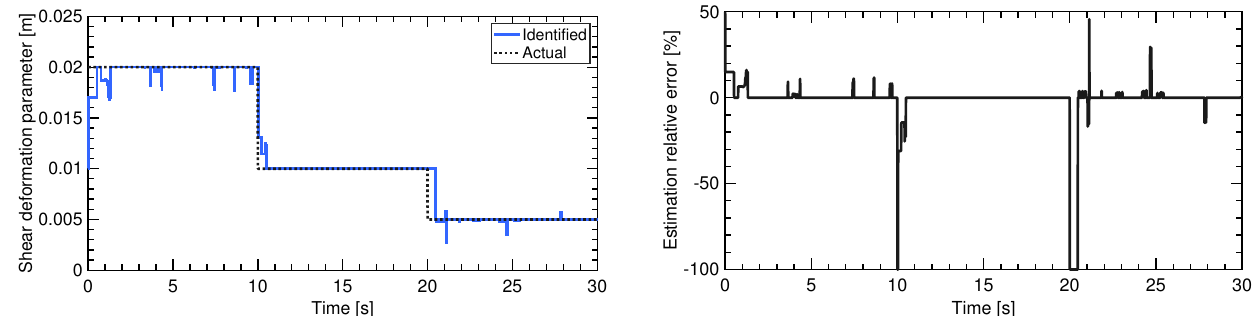
Figure 35. Identification of shear deformation parameter: identified value ( left ) and relative error ( right ). Different settings of the window size for the number of measurement samples were tested. It was concluded that fifty samples provided robust behavior and were not compu- tationally demanding at the same time. Additionally, the maximum number of iterations was set to twenty. In case when the algorithm was unable to converge, the last converged value was provided at the output. The number of iterations for each time step is presented in Figure 36.